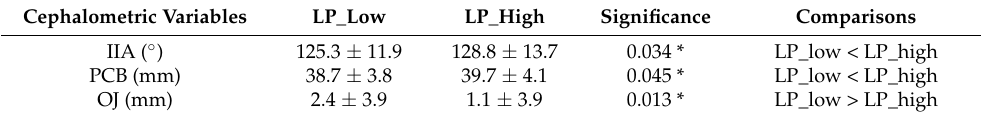
Table 5. Comparisons of cephalometric variables between LP_low and LP_high groups (n = 194). * Cephalometric